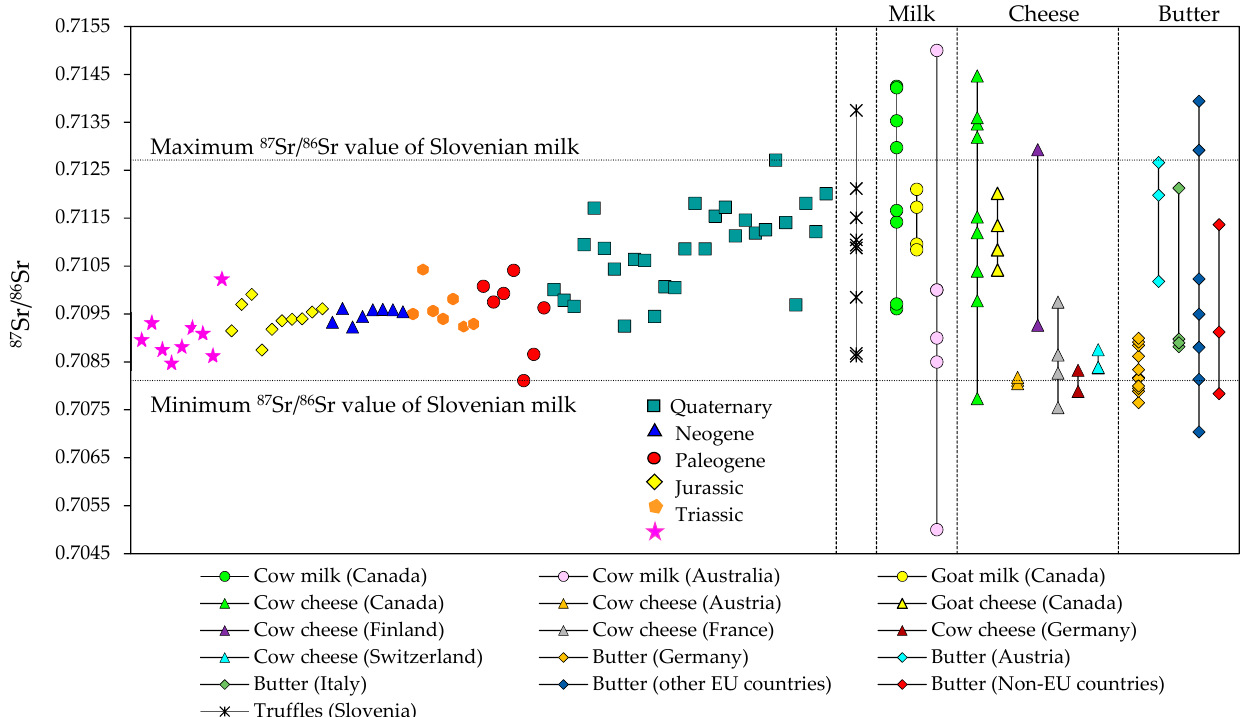
Figure 3. The 87 Sr/ 86 Sr isotope ratios in various dairy products from different countries, as reported in the literature. Horizontal dashed lines define the limits of the 87 Sr/ 86 Sr values measured in Slovenian milk of different geological regional origins, as indicated. References used for various dairy products worldwide: butter [24], cheese [27,30], and milk [29,30]. Dots on the vertical lines refer to the results obtained from the literature, whereas lines indicate the span of values. The 87 Sr/ 86 Sr isotope ratios in Slovenian truffles are also presented [39].